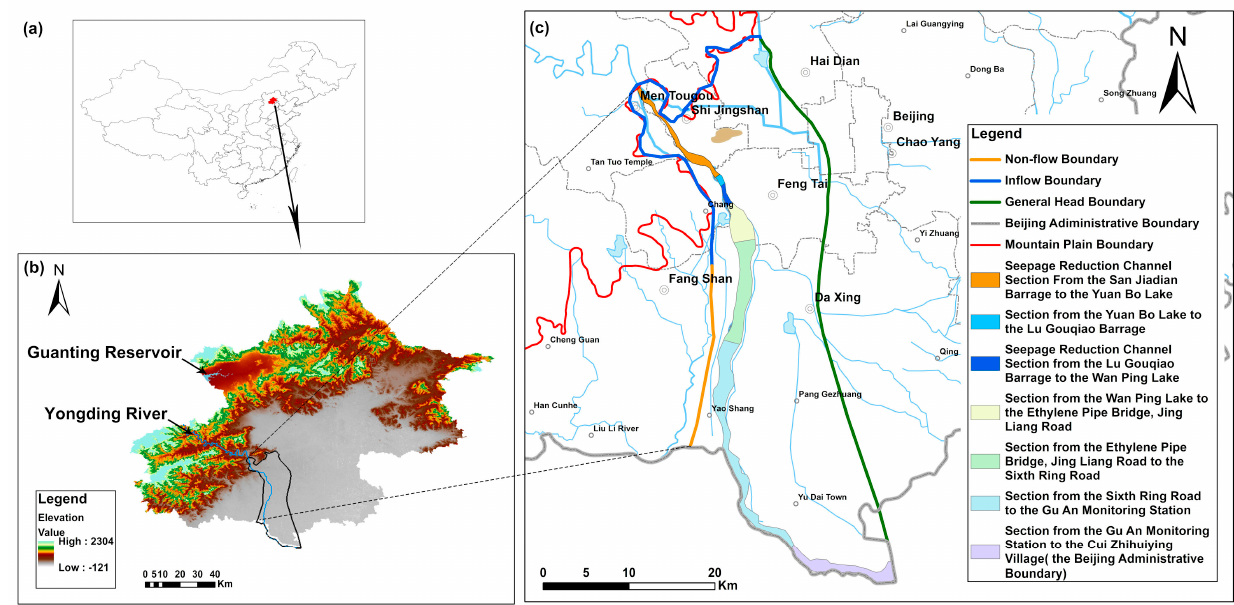
Figure 3. ( a , b ) Location and terrain distribution of the alluvial fan of the Yongding River. ( c ) Schematic diagram of generalization of the model boundary and each Yongding River ecological water supplement monitoring section.